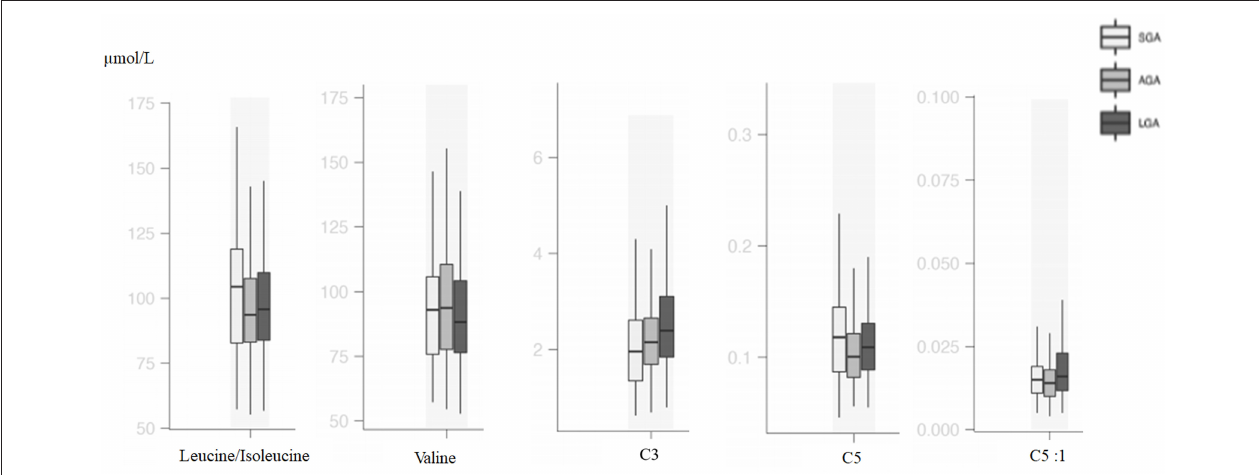
FIGURE 3 | Box and whisker plots of metabolic parameters associated with branched-chain amino acid metabolism among groups.